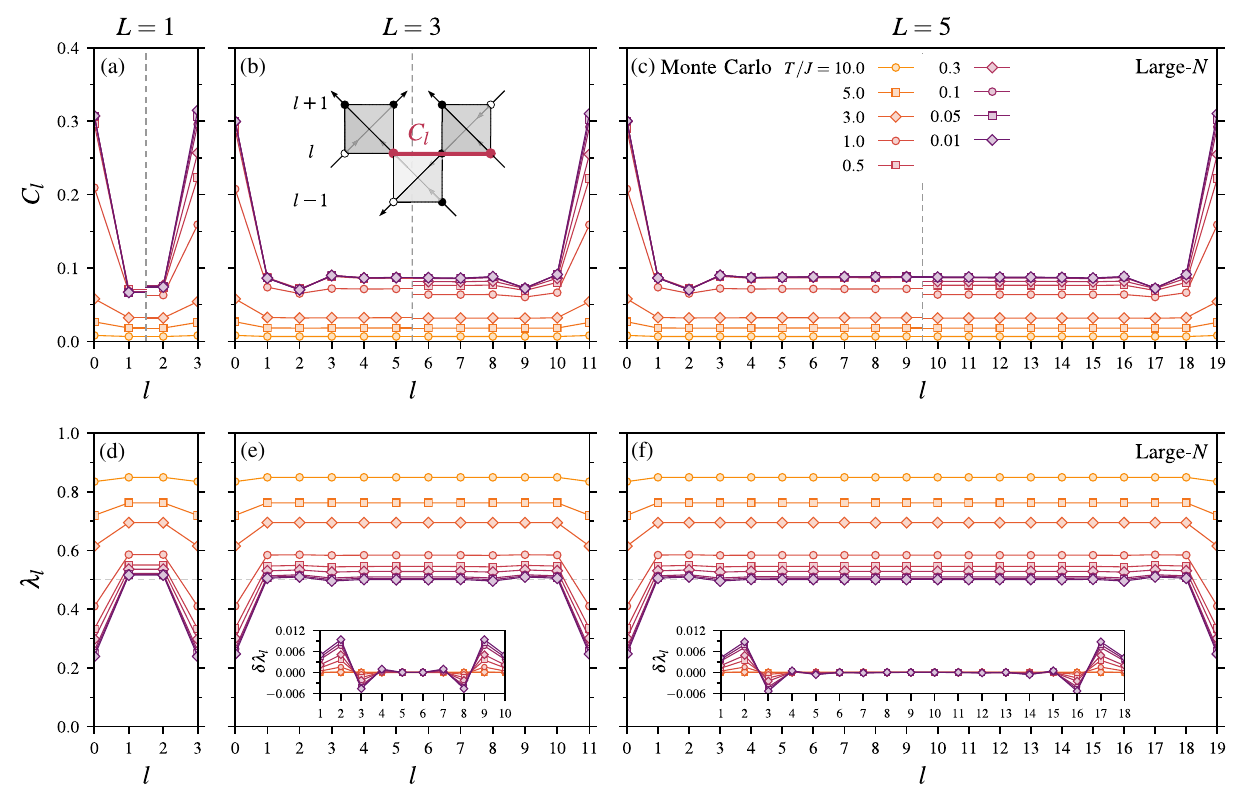
FIG. 4. Layer-resolved real space correlations C l (a) – (c) [see the inset of (b) for a definition of C l ] and constraint fields λ l (d) – (f) of thin films of (a,d) 4 layers ( L ¼ 1 ), (b,e) 12 layers ( L ¼ 3 ), and (c,f) 20 layers ( L ¼ 5 ), as a function of temperature T=J and layer index l (see Fig. 3). For the real space correlations, the Monte Carlo result (left) is shown for a system size of L results (right) are effectively in the thermodynamic limit ( L ⊥ ¼ ∞ ). In panels (d) – (f), the dashed lines show the value λ 0 ¼ 1 = 2 expected for bulk spin ice at T=J ¼ 0 , and the insets show the deviation from the central layers, δλ l ≡ λ l − λ 2 L